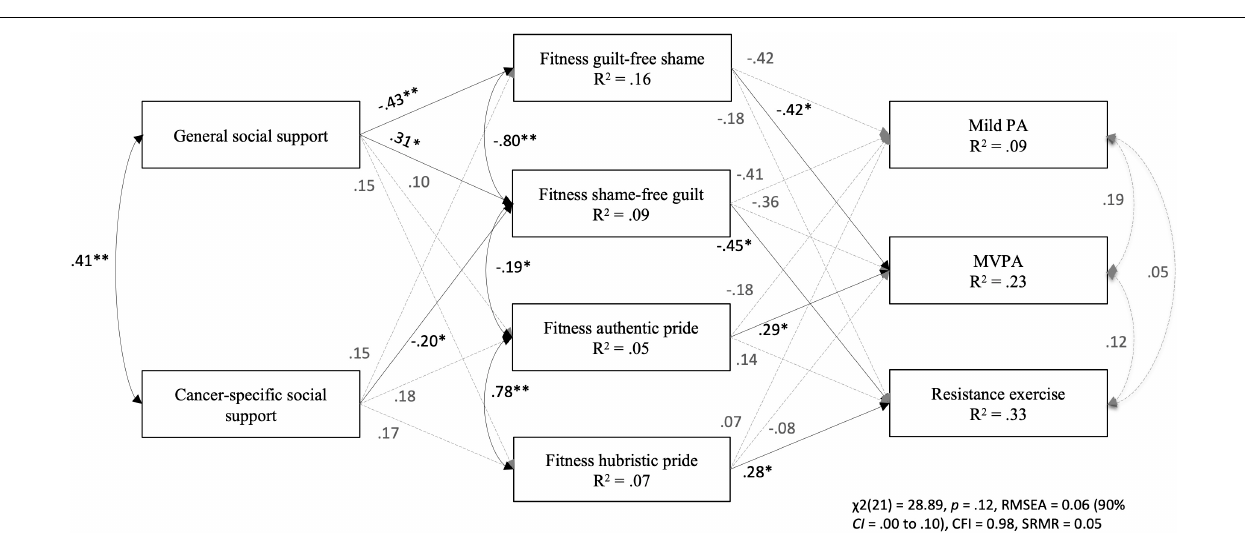
FIGURE 1 | Standardized path coefficients and explained variance of the model in predicting social support, appearance-related emotions, and physical activity. Note. Covariates included in the model are age, gender, and time since diagnosis. Variance explained for each endogenous variable are reported within the observed variable boxes. None of the indirect effects were significant. PA = physical activity; MVPA = moderate-to-vigorous physical activity. * p < 0.05; ** p < 0.001.